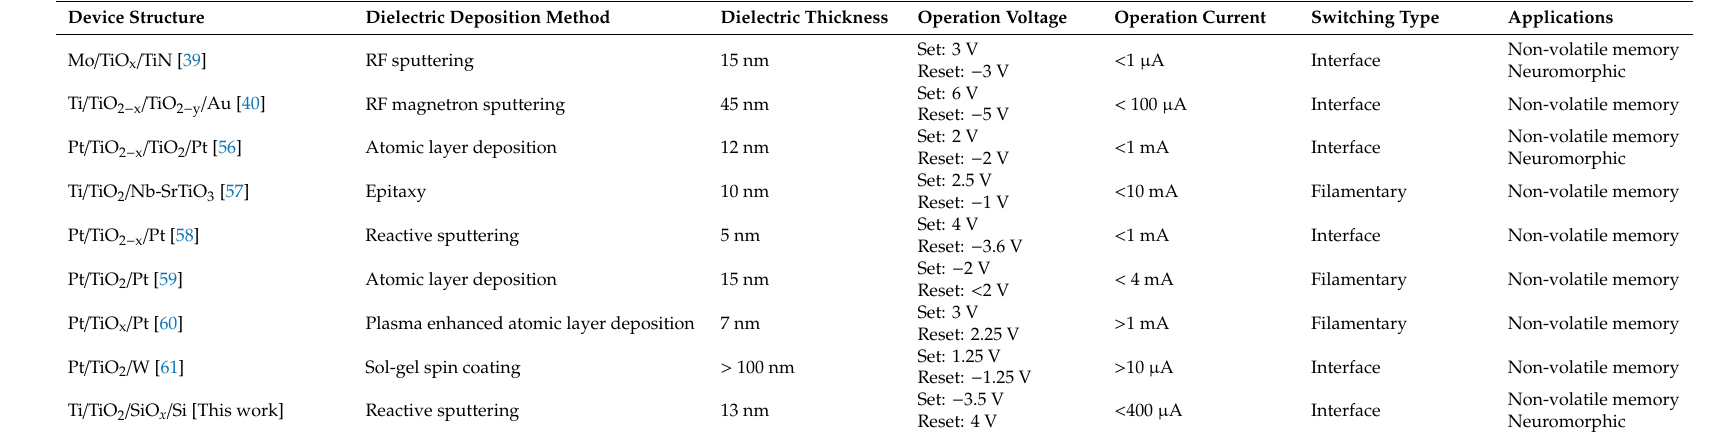
Table 1. Comparison of TiO x -based Resistive random access memory (RRAM) devices prepared by di ff erent